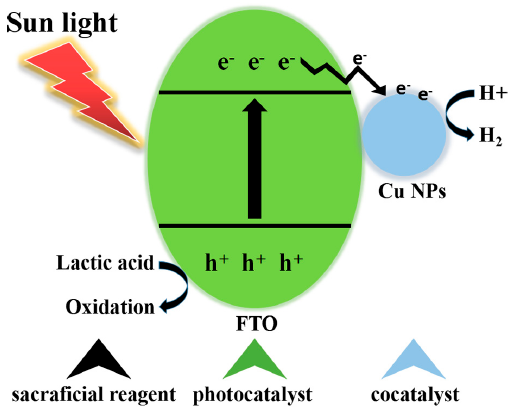
Figure 12. Schematic mechanism for photocatalytic H 2 evolution on the Cu/FTO system.